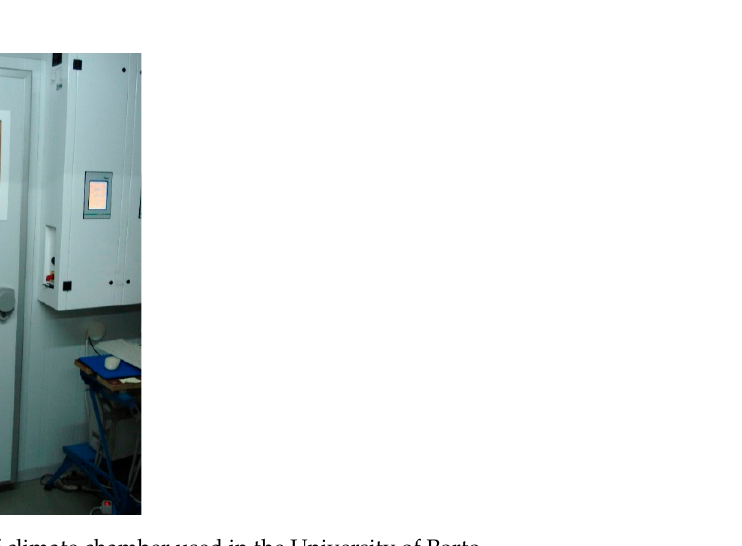
Figure 1. Example of climate chamber used in the University of Porto.